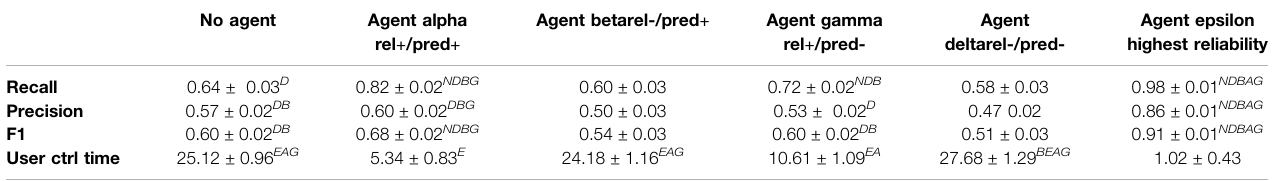
TABLE 1 | Metrics related to performance (Recall, Precision and F1, higher (cid:2) better) and reliance (User control time (in seconds) higher (cid:2) less reliance on the agent). Superscript letters next to the results indicate which agents yielded signi fi cantly worse scores ( p < 0 . 05).